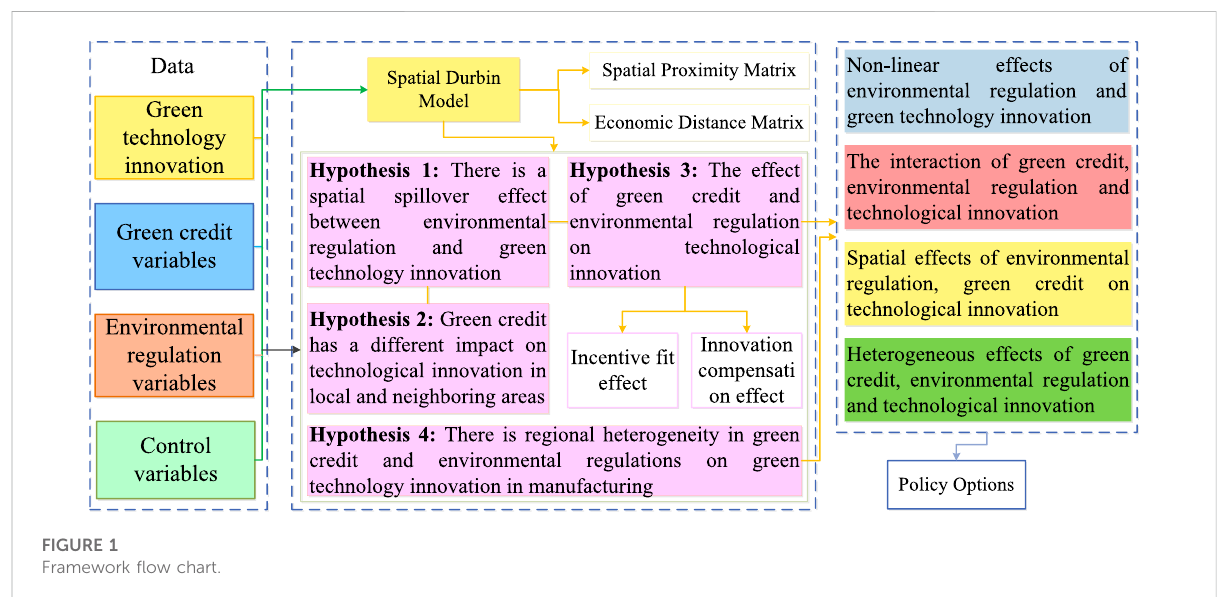
FIGURE 1 Framework fl ow